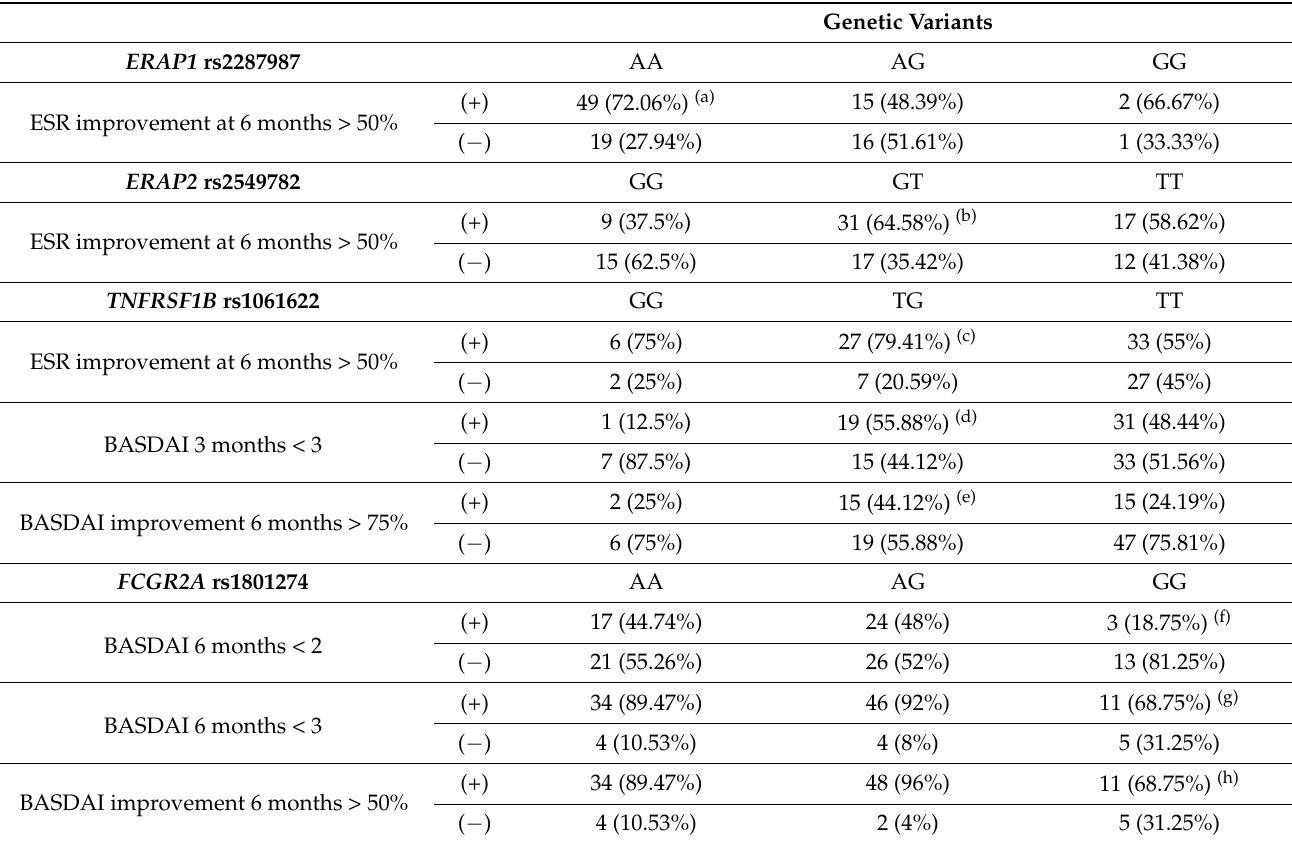
Table 5. Statistically significant relationships in the assessment of anti-TNF treatment